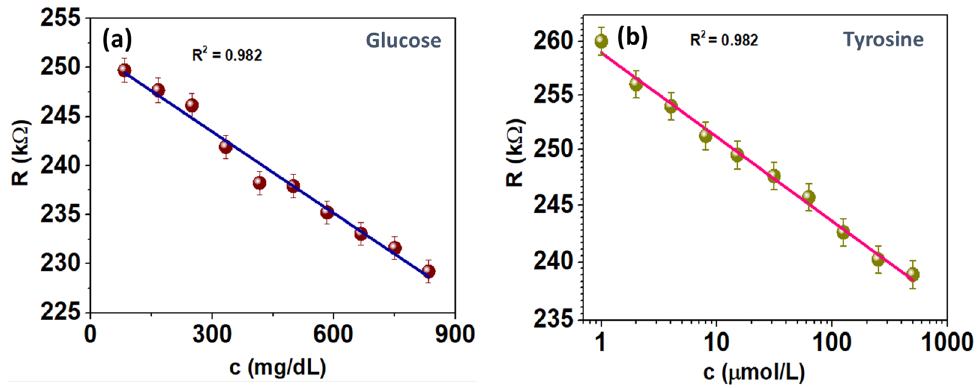
Figure 6. Sensing performance of portable resistive module towards monitoring ( a ) glucose; ( b ) tyrosine at 5V DC supply.